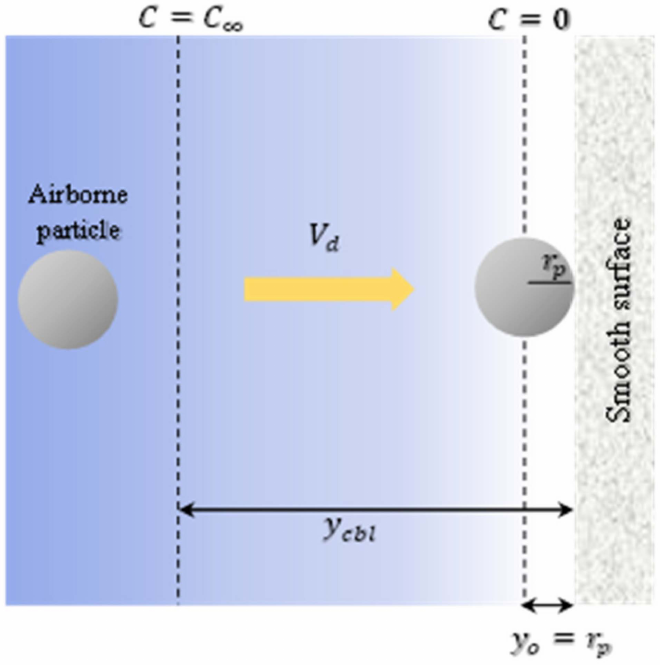
Figure 1. Schematic diagram for dry deposition on a smooth surface of airborne particle with radius r p across the concentration boundary layer. The concentration of particle number across the boundary layer grows from lowest value ( C = 0) at height y 0 (= r p ) to its highest value ( C = C ∞ ) at height y cbl . V d is the dry deposition velocity through the concentration boundary